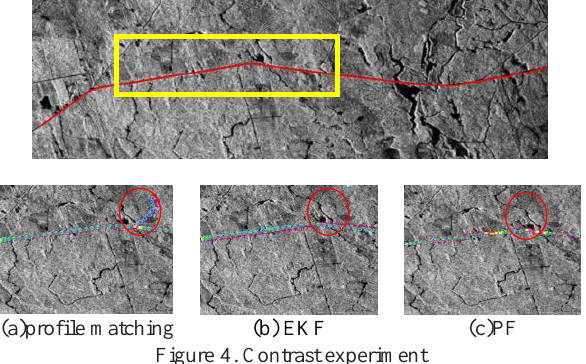
Figure 4. Contrast experiment